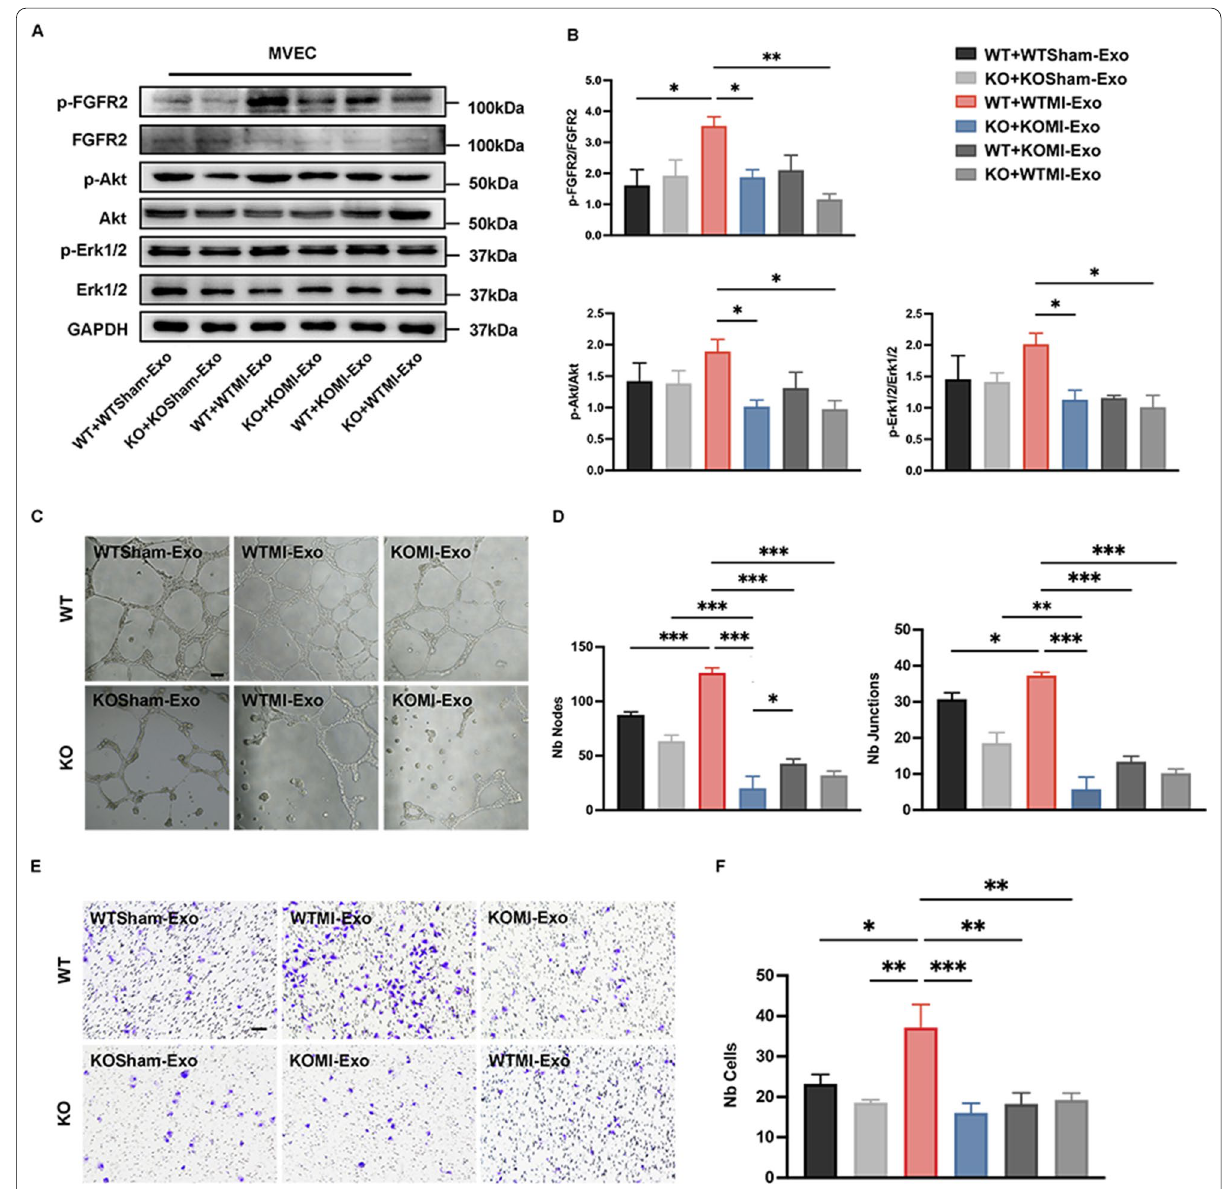
Fig. 5 CD44 promotes plasma exosome proangiogenic function by enhancing FGFR2 signaling transduction. A , B Western blot analysis of the activation of the FGFR2 pathway after 48 h coculture of WT MVECs with WTSham plasma exosomes (WT WTSham-Exo), KO MVECs with + KOSham plasma exosomes (KO KOSham-Exo), WT MVECs with WTMI plasma exosome (WT WTMI-Exo), KO MVECs with KOMI plasma exosomes + + (KO KOMI-Exo), WT MVECs with KOMI plasma exosomes (WT KOMI-Exo), and KO MVECs with WTMI plasma exosomes (KO WTMI-Exo), + + + respectively. n 3. C The tube formation assay was used to test the angiogenic function of plasma exosomes (WTSham-Exo, KOMISham-Exo, = WTMI-Exo, and KOMI-Exo) in WT and KO MVECs. Scar bar: 50 μm. D The statistical data of the number of nodes (Nb Nodes) and the number of junctions (Nb Junctions). n 3. E CD44 WT and KO MVECs were co-cultured with WTSham-Exo, KOSham-Exo, WTMI-Exo, and KOMI-Exo for 48 h, and = the ability of cell migration was detected through the Transwell migration assay. Scale bar: 100 μm. F The numbers of cells (Nb Cells) that migrated through the inserts were counted and compared between groups statistically. n 3. * P < 0.05, ** P < 0.01, *** P < =